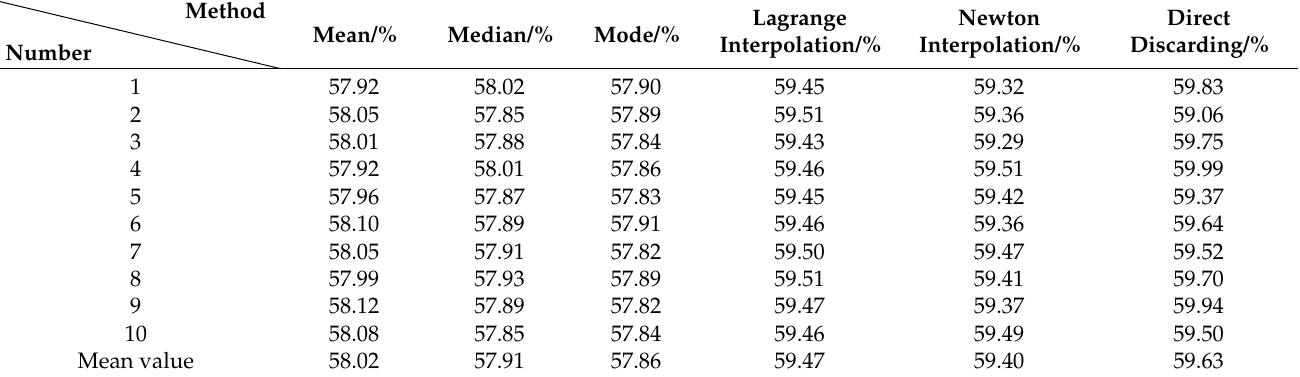
Table 5. Prediction accuracies achieved by the RF classifier on six